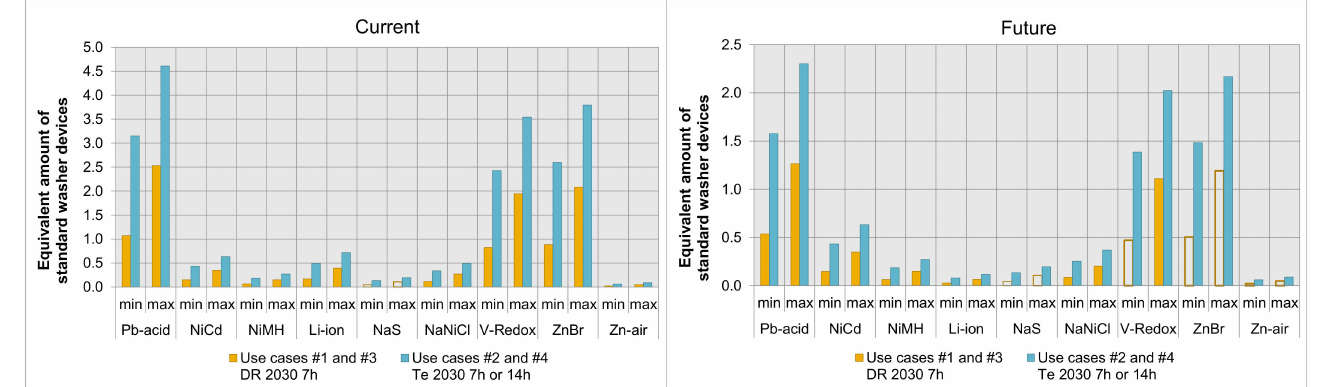
Figure 8. Volumetric analogy illustrating the number of standard washer devices required in all case